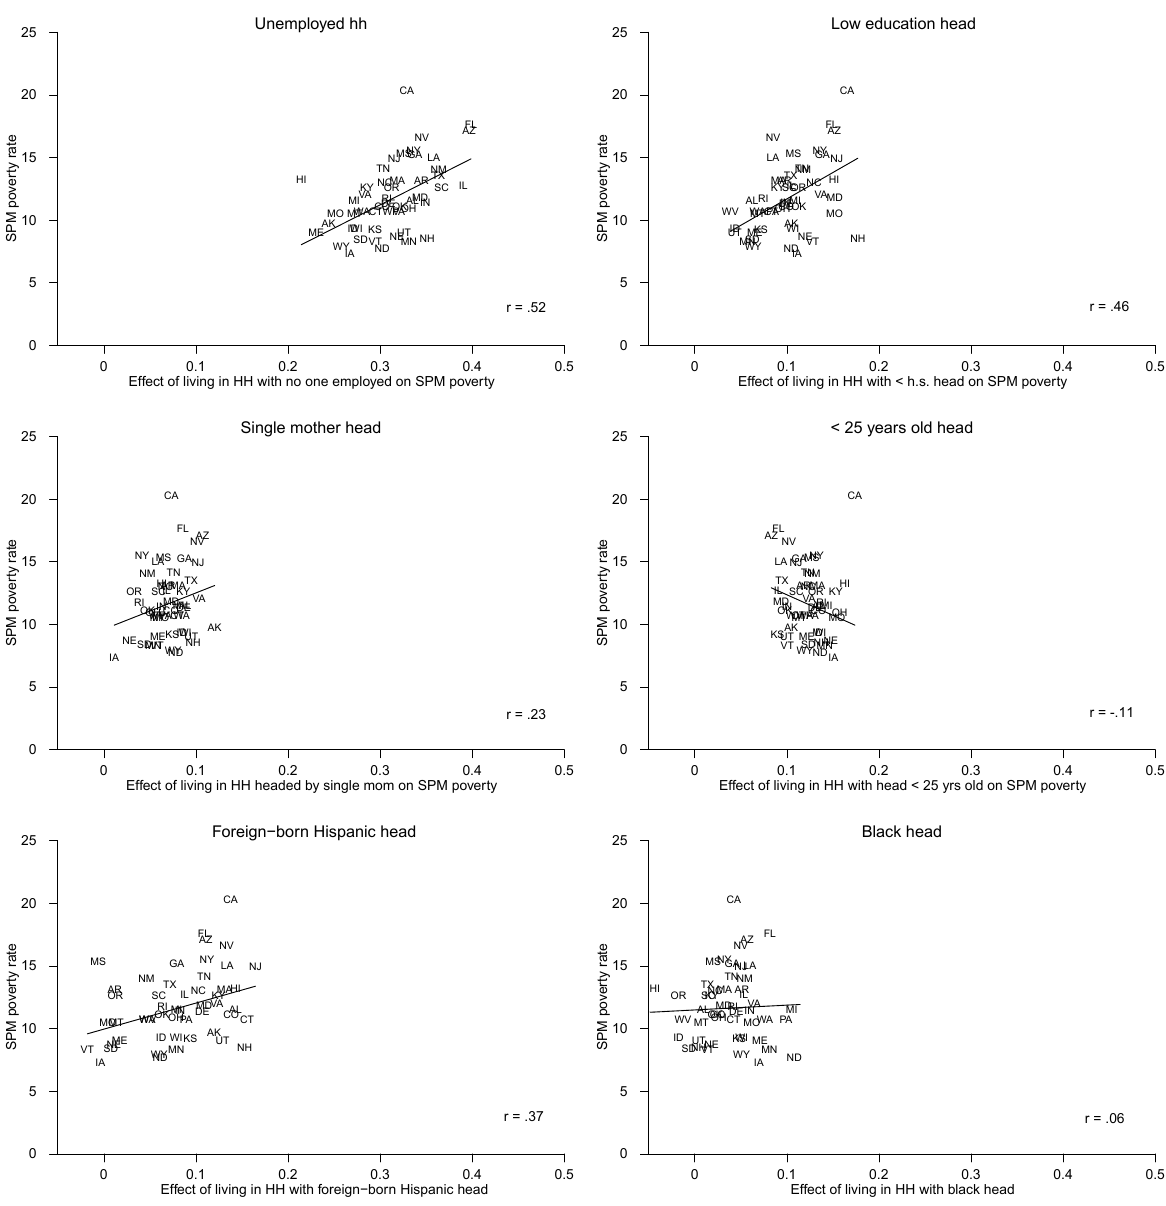
Figure3: Bivariate relationship between risk penalties and SPM poverty rates (2012–2016 CPS). Adjustments for SNAP, SSI, and TANF underreporting were made using the Urban Institute Transfer Income Model (TRIM). Effects represent coefficients from varying slope linear probability models predicting SPM poverty. The nonvarying slopes in the model are year fixed effects and a control for metropolitan and/or nonmetropolitan status. States are indicated by their postal code abbreviations. Penalties before and after Taxes and Transfers Figures 4 through 9 below show penalties before and after taxes and transfers (vertical lines represent 95 percent confidence